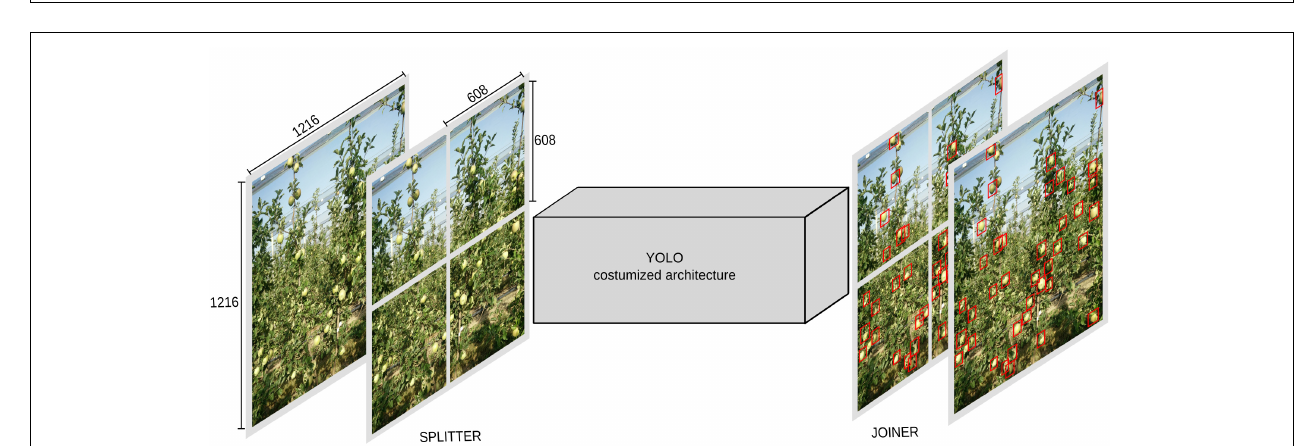
FIGURE 2 | Model M3, with splitter and joiner blocks.